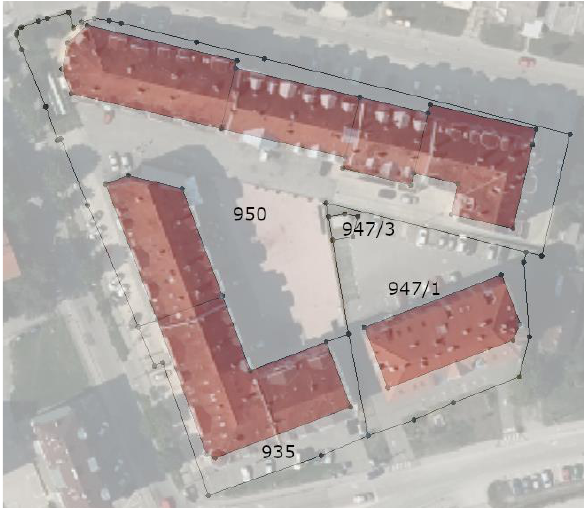
Figure 2 . Cadastral map data: land parcel boundaries and buildings